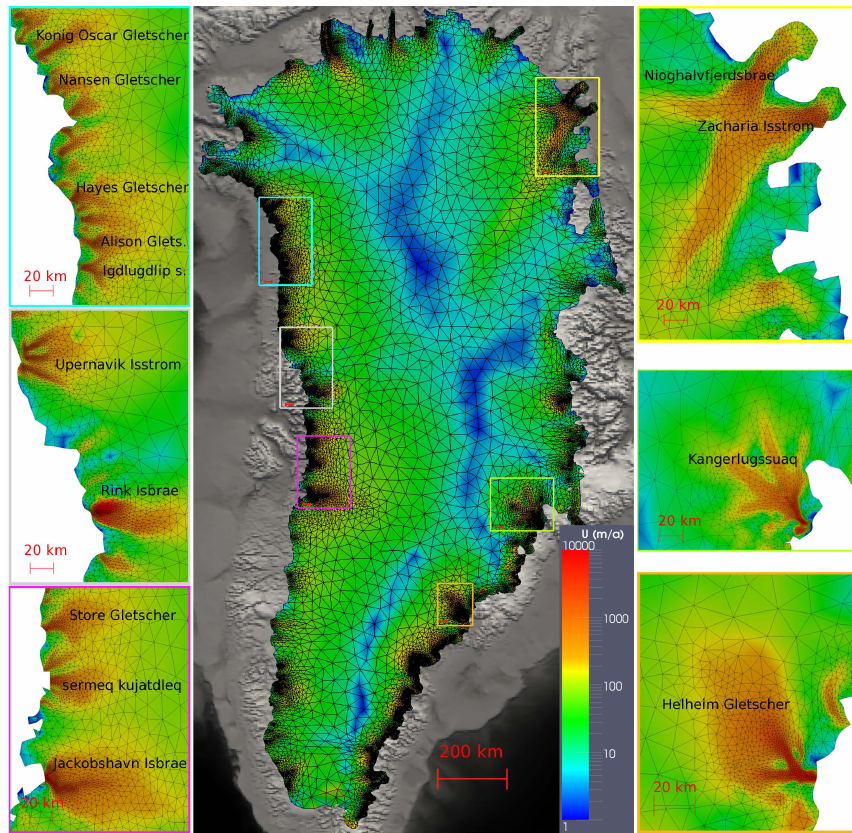
Fig. 2. Unstructured finite element mesh and model surface velocities after optimisation of the basal friction coefficient with the Robin inverse method. Colored boxes show close-up views for various outlet glaciers of